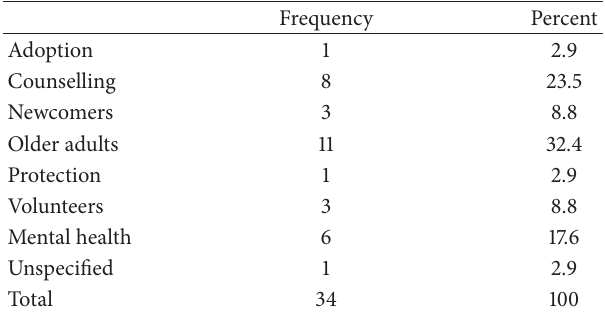
Table 2: Participants by JCFS service